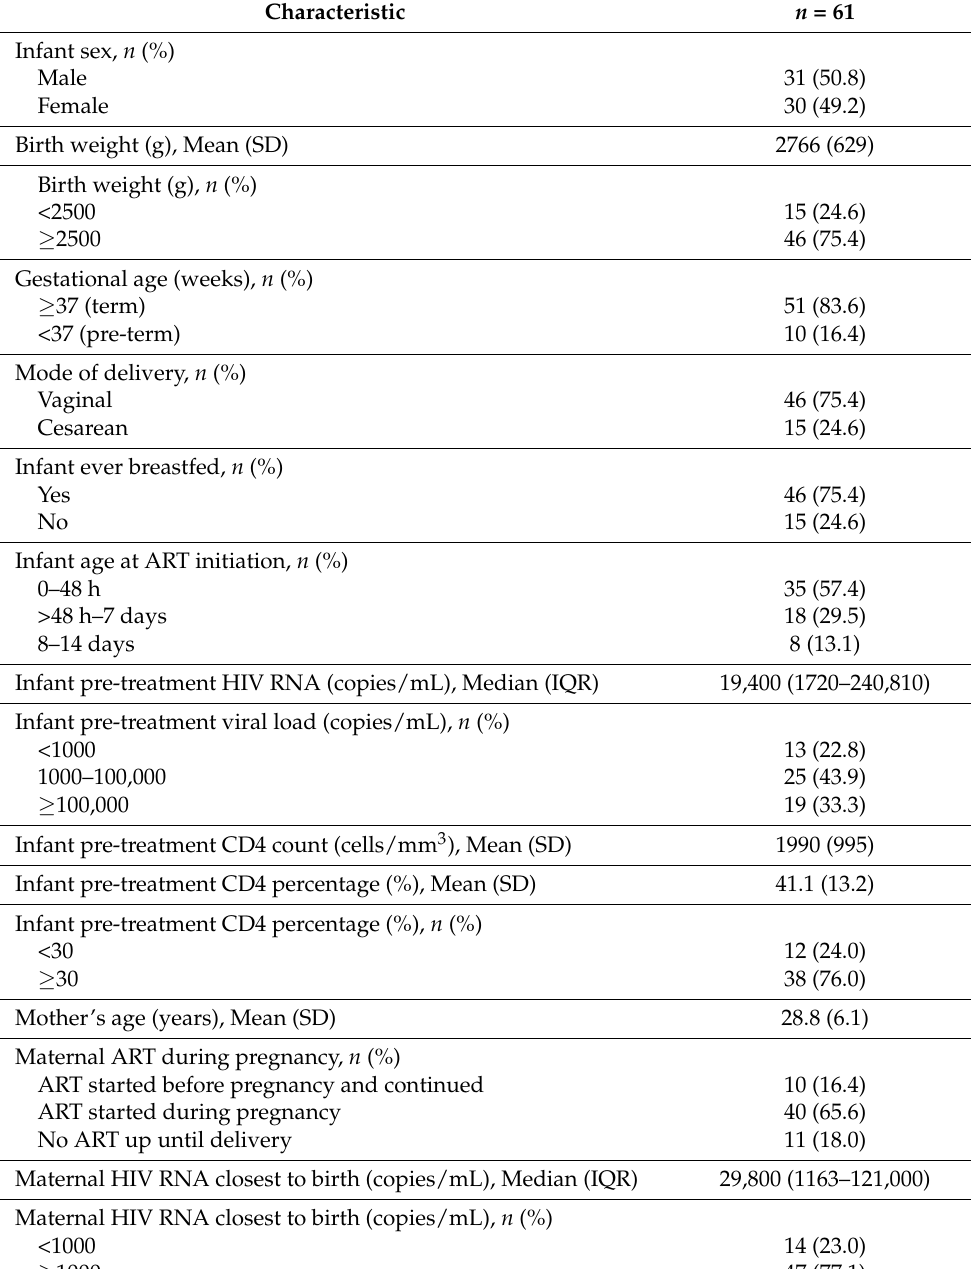
Table 1. Characteristics of 61 intrauterine HIV-infected neonates and their mothers enrolled at Rahima Moosa Mother and Child Hospital in Johannesburg, South